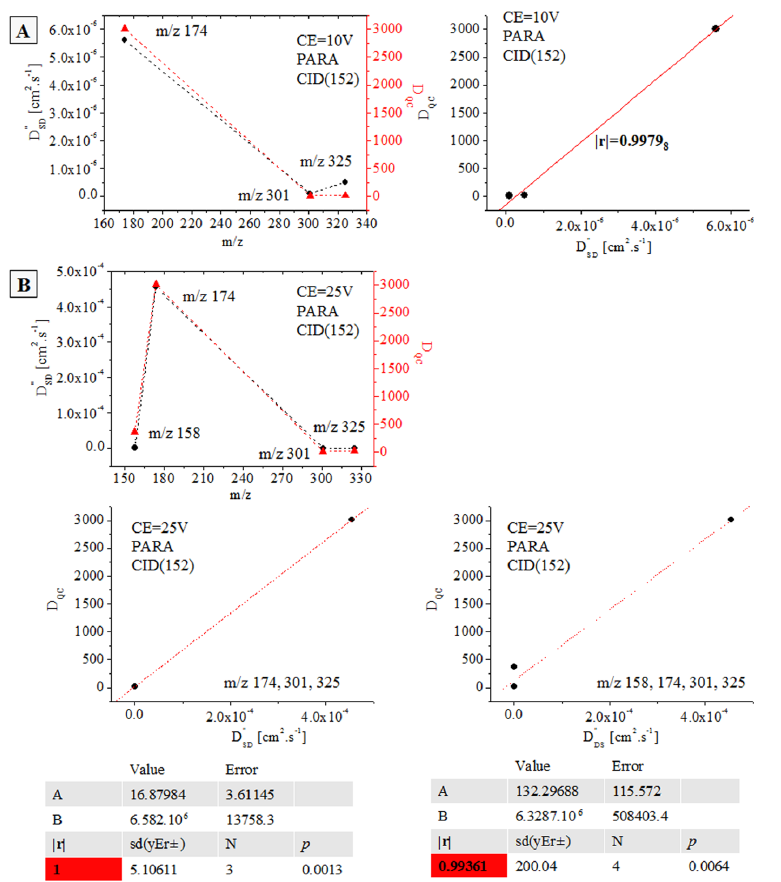
Figure 7. Functional relationships between D” SD [cm 2 .s − 1 ] and D QC data on Equations (2) and (3) of fragmentation ions of CID-MS/MS reactions of molecular ion [M+H] + of paracetamol at CE 10 ( A ) and 25 ( B ) V; chemometrics.